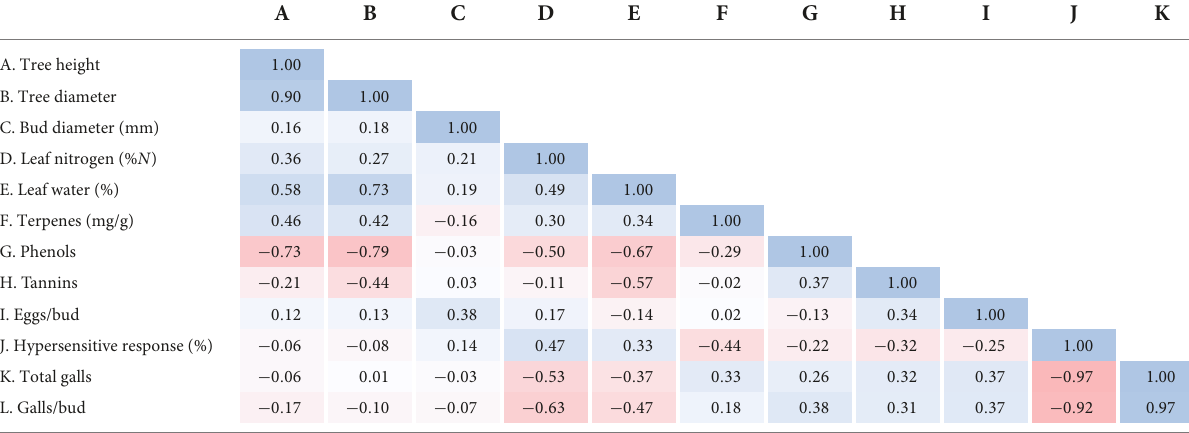
TABLE 4 Correlation matrix (Pearson correlation coefficients) of genotype-specific attributes. A B C